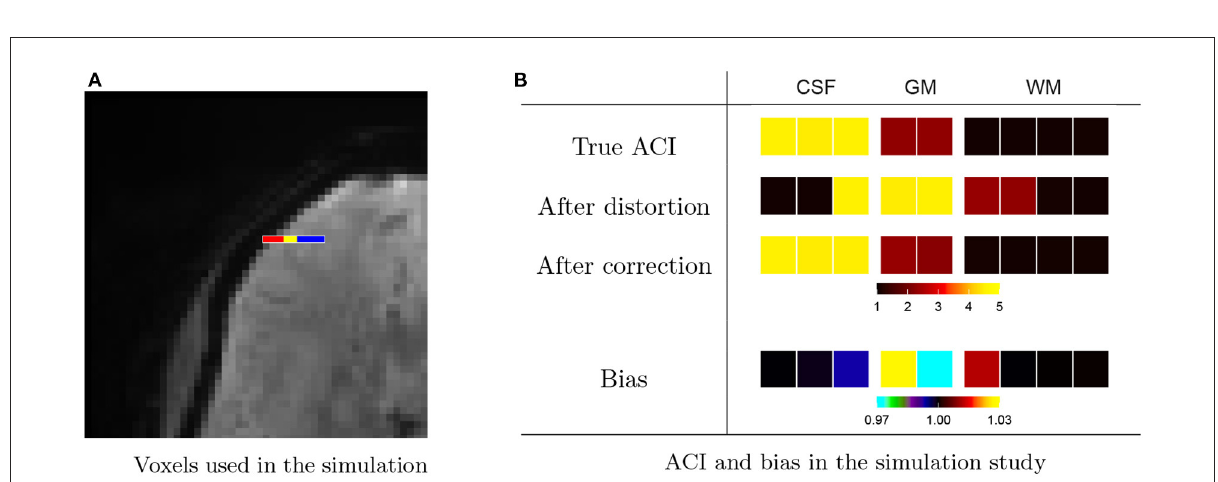
FIGURE7 Effect of distortions on the spatial topology of autocorrelation. (A) A nine-voxel sequence contains three voxels from cerebral spinal fluid (CSF, red), two voxels from gray matter (GM, yellow), and four voxels from white matter (WM, blue). These were padded by 26 background voxels on the left and 15 additional WM voxels on the right to avoid edge effects. (B) An AR(3) was used to generate autocorrelated timeseries within each tissue class, resulting in the true autocorrelation indices (ACI) shown on the top row. The ACI of the timeseries after after forward-direction distortion are shown on the second row and after distortion correction on the third row. While distortion correction clearly helps to resolve changes in ACI induced by the distortions, the fourth row shows that there is still bias (after/true) present after correction. Namely, the GM voxel neighboring CSF has increased ACI, and the GM voxel neighboring WM has decreased ACI. There is also a lesser amount of bias in the CSF and WM voxels neighboring GM.